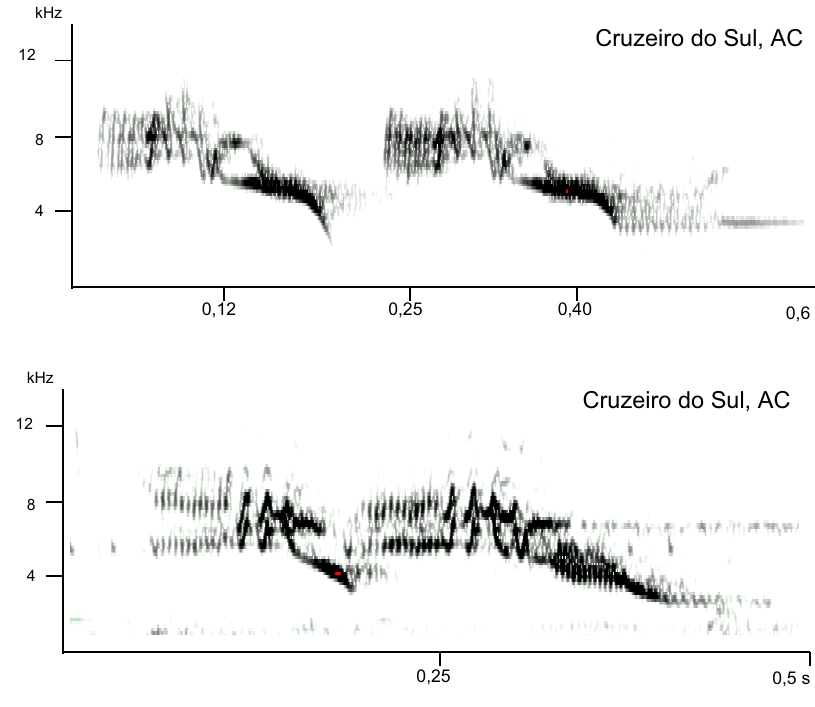
Fig. 9 – Repetitions: two cases of individual singers showing long sections of their song